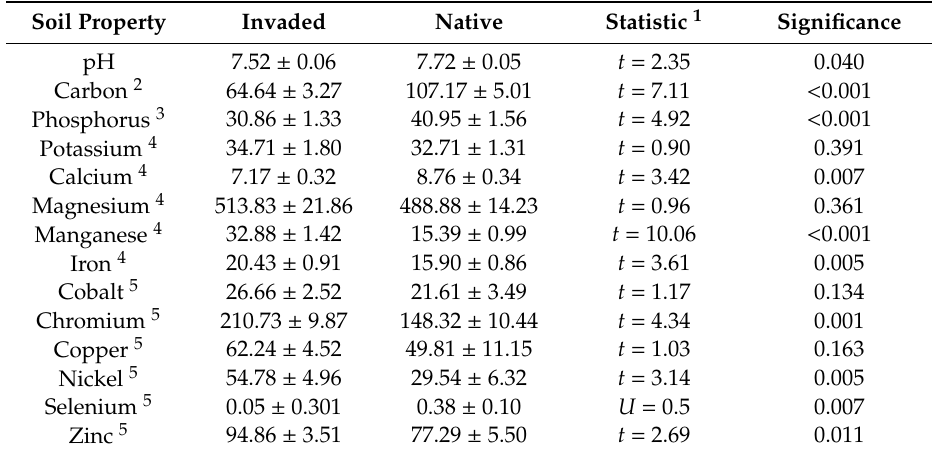
Table 4. The chemical properties of Guam cobbly clay soils within invaded mature stands of. Spathodea campanulata and in adjacent native forest in central Guam. Means ± SE, n =